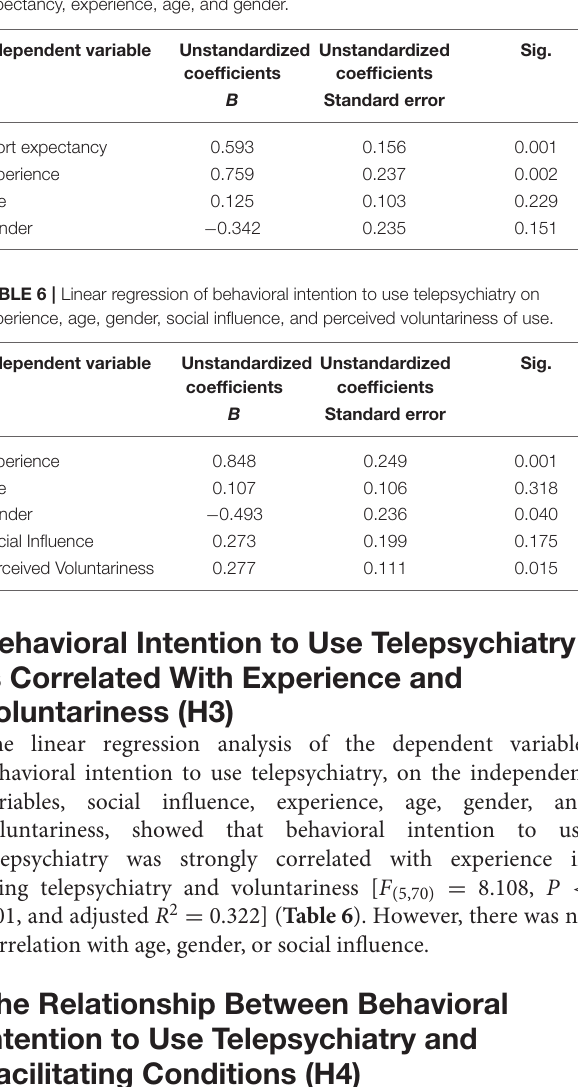
TABLE 5 | Linear regression of behavioral intention to use telepsychiatry on effort expectancy, experience, age, and gender.